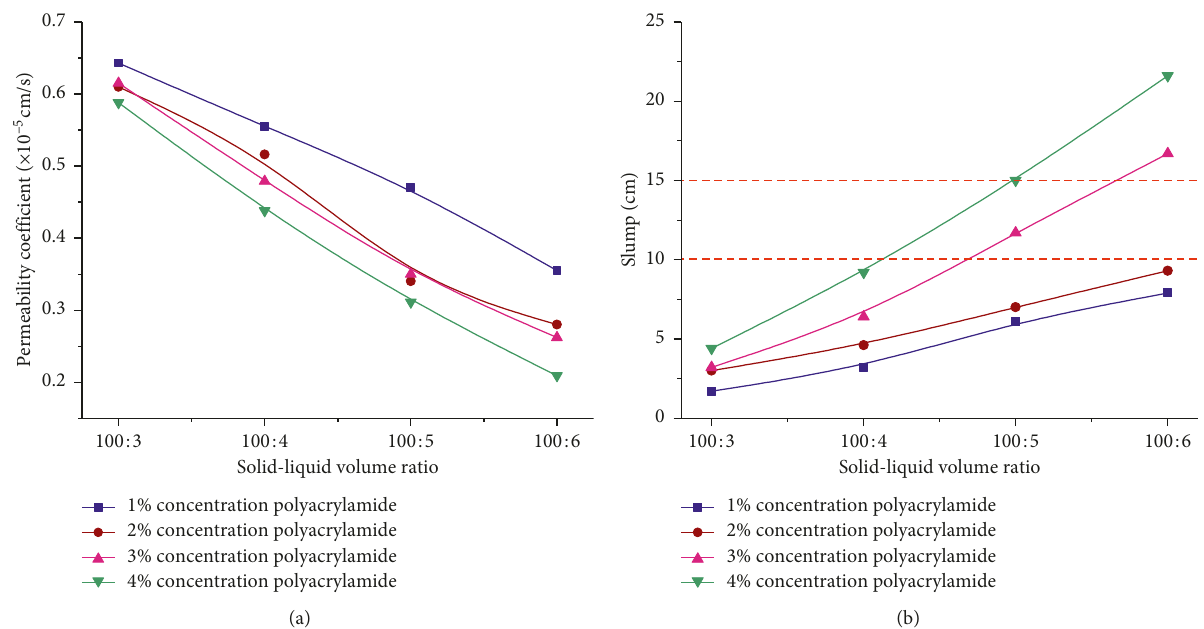
Figure 8: Improvement of the performance of the slag with the solid-liquid volume ratio of mixed mud. (a) Slag permeability coefficient. (b) Slag slump.